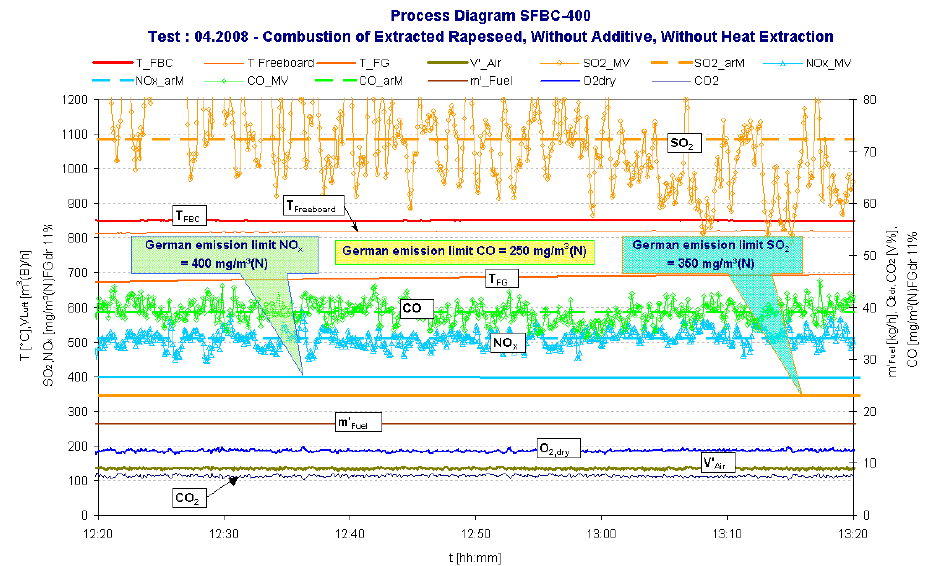
Figure 2. Process diagram of the test run.